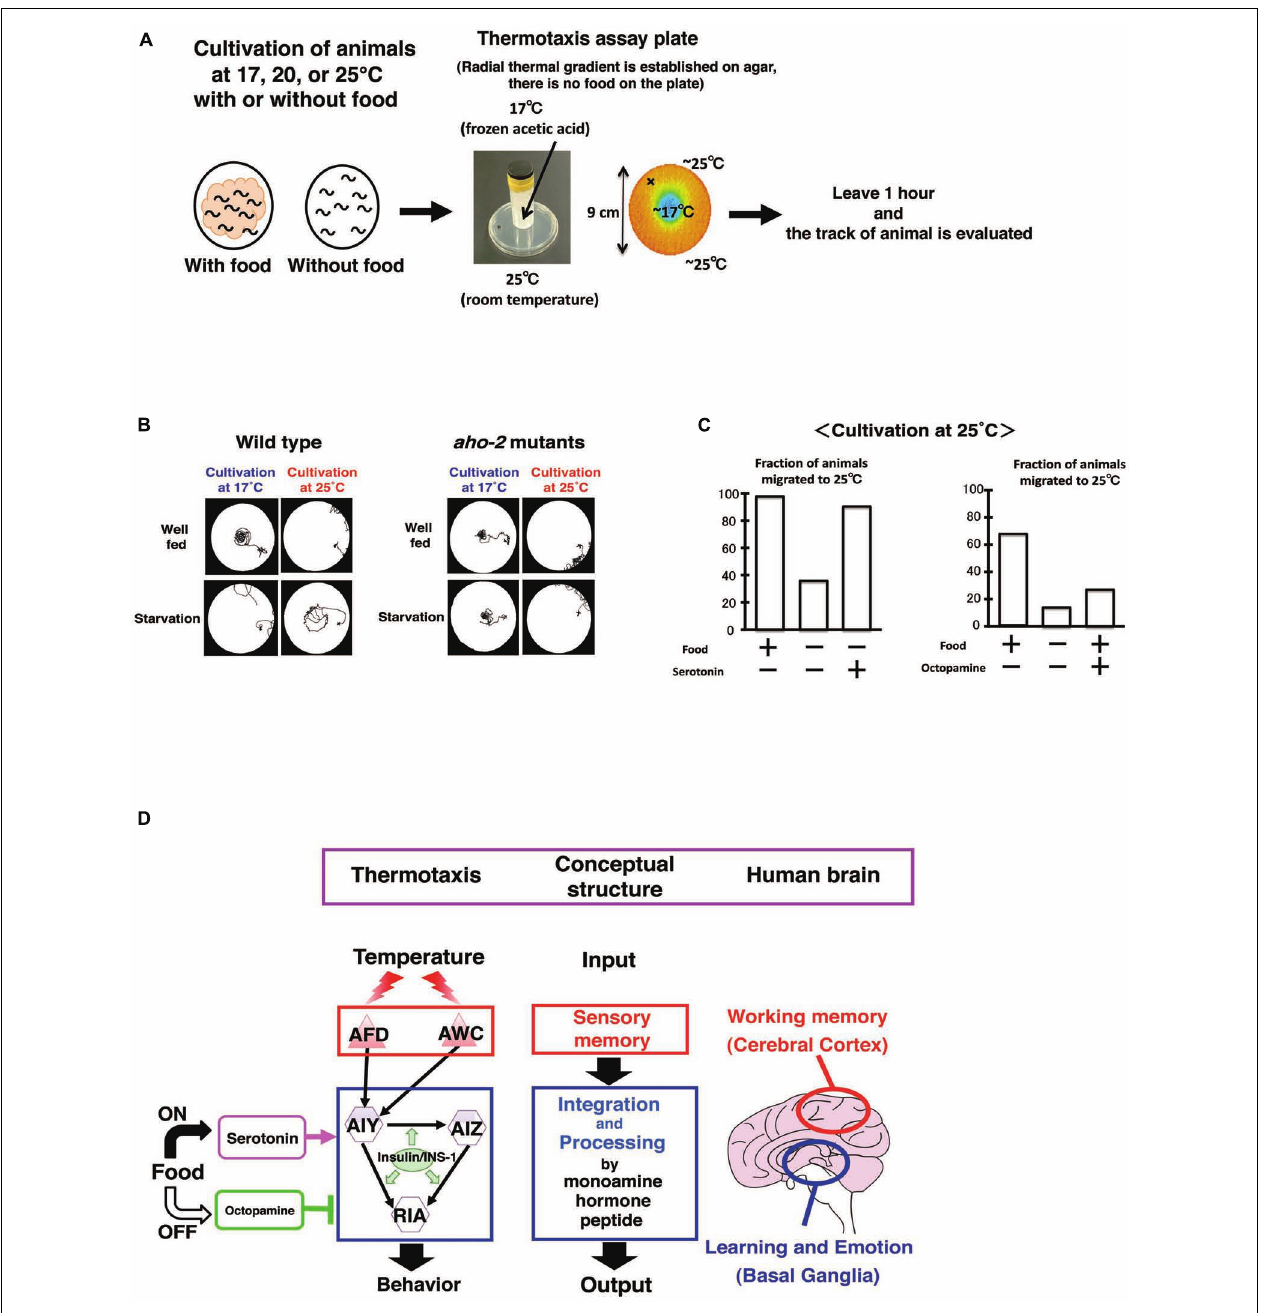
FIGURE 8 | Circuit regulation of associative learning between temperature and food (Hedgecock and Russell, 1975; Mori and Ohshima, 1995; Mohri etal., 2005; Kodama etal., 2006; Sasakura and Mori, 2013). (A) Assay system and scheme for experiments. (B) Thermotaxis of wild type animals and aho-2/ins-1 mutants.Wild type animals cultivated with food at 17 or 25 ◦ C migrate to the past growth temperature on a radial thermal gradient plate. In contrast, wild type animals cultivated without food (starvation conditions) diffuse and avoid the growth temperature area.The aho-2/ins-1 mutants exhibited normal thermotaxis when grown with food, but exhibited abnormal thermotaxis when grown without food. Despite the starvation conditions, aho-2/ins-1 mutants migrate to the past growth temperature. (C) Exogenous serotonin mimics the well-fed state and octopamine mimics the starvation state in thermotaxis. C. elegans grown at 25 ◦ C without